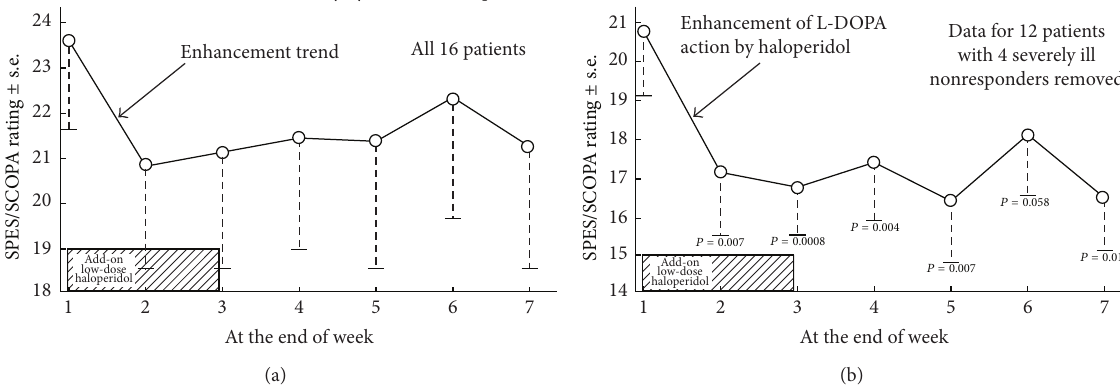
Figure 1: An add-on oral dose of 40 𝜇 g haloperidol per day enhanced the effectiveness of levodopa in treating Parkinson disease patients, as monitored by the SCOPA ratings. (a) Data for all 16 patients. (b) Data for 12 patients, where four advanced stage patients were omitted. Data in Tables 1 and 2.